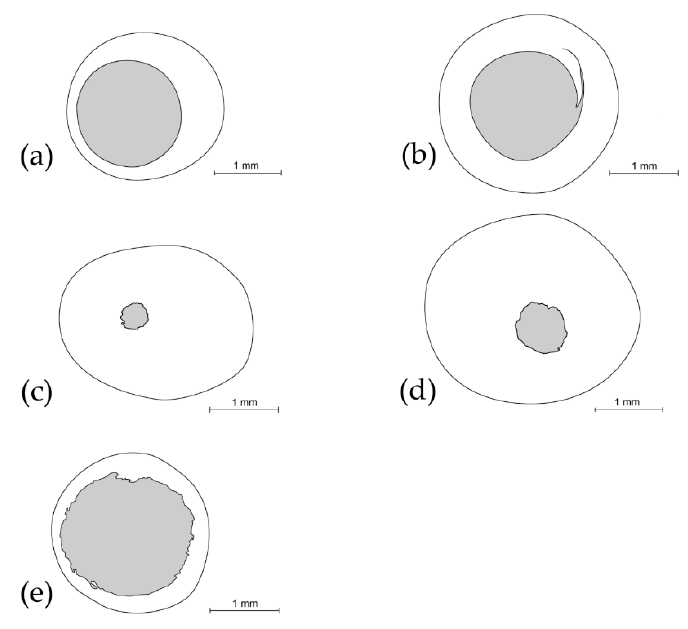
Figure 1. Examples of apertures in cocoons made by ( a ) the Chrysopidae family, by the most abundant parasitoid species: ( b ) Helorus ruficornis , ( c ) Baryscapus impeditus and ( d ) Isodromus puncticeps and by ( e ) predators.